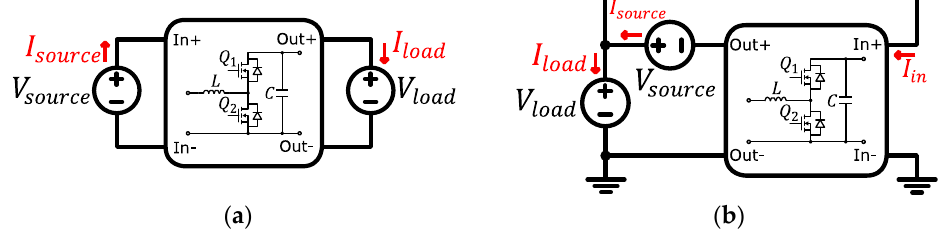
Figure 3. HB topology implemented on a ( a ) FPC architecture and a ( b ) FC-type PPC architecture.